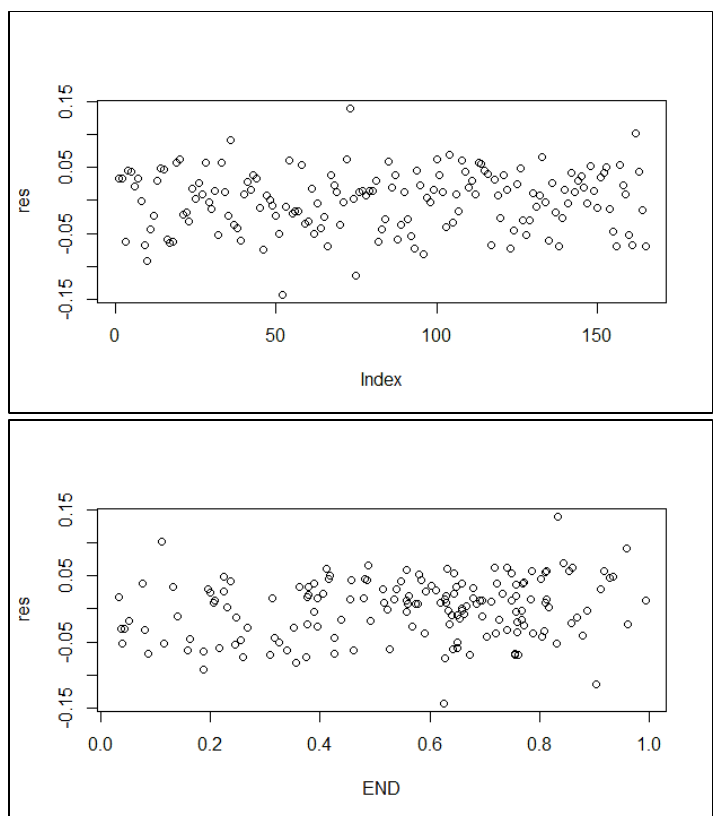
Figure 2. Diagrams of the